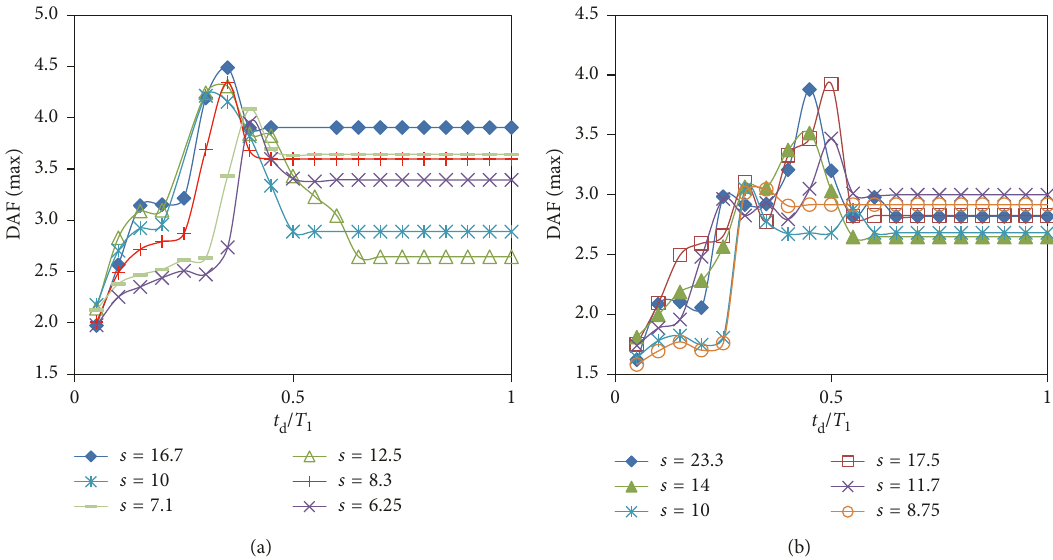
Figure 10: Maximum DAF of shear force of bridge columns with different slenderness ratios subjected to rectangle load pulse. (a) F-F. (b)